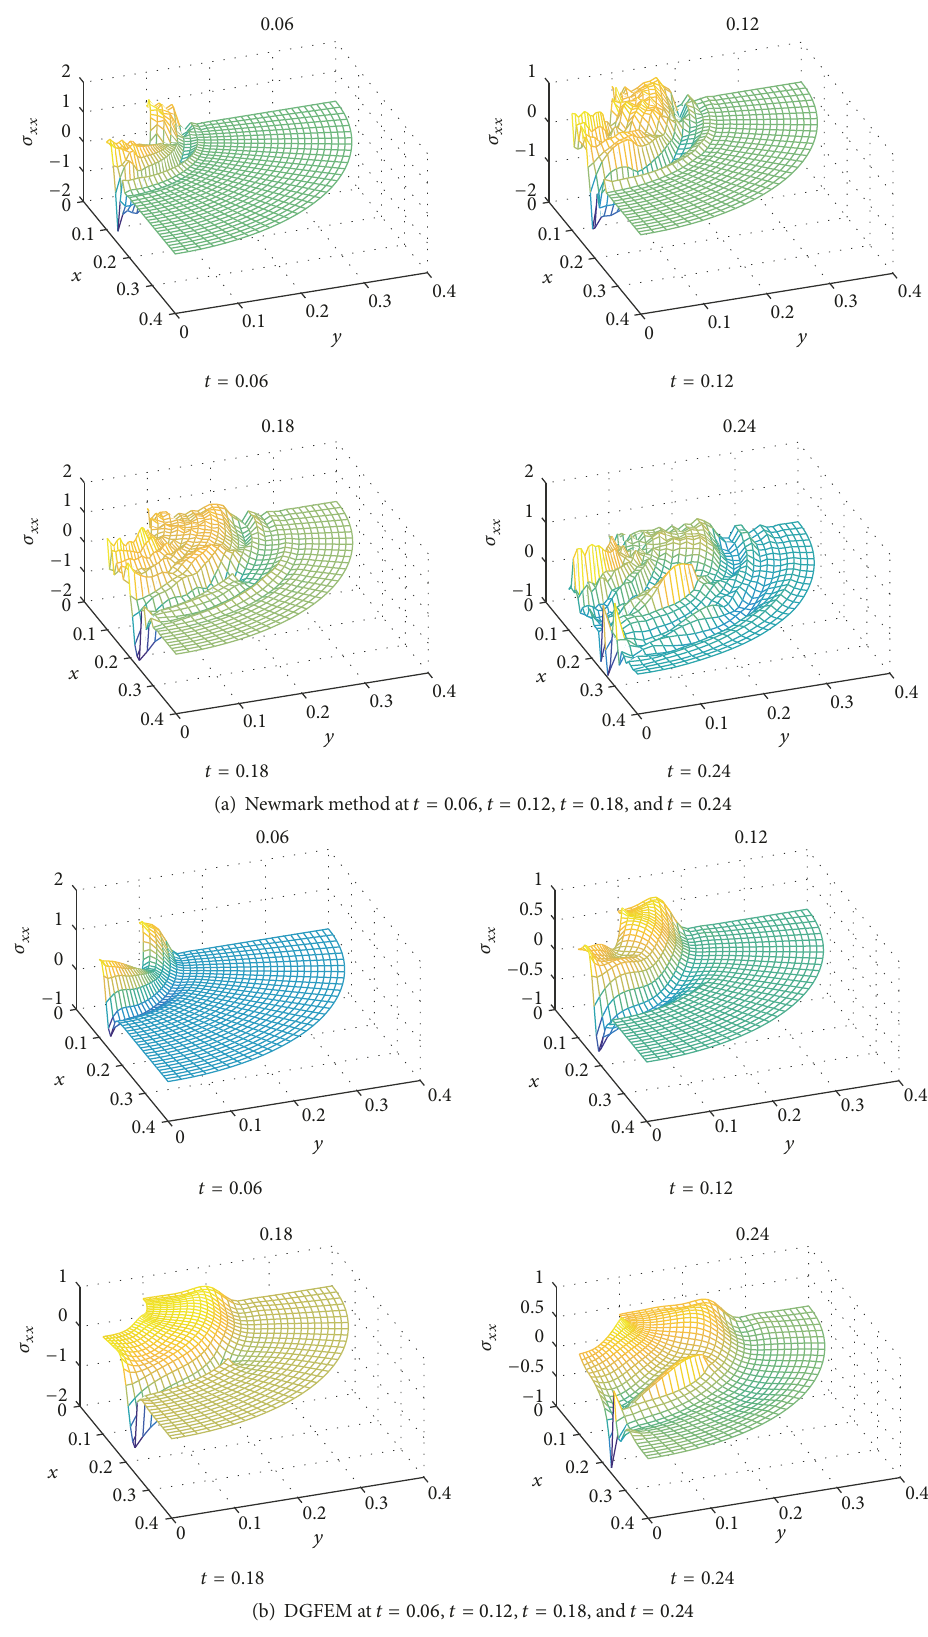
Figure 6: Comparison of displacement profiles between Newmark method and